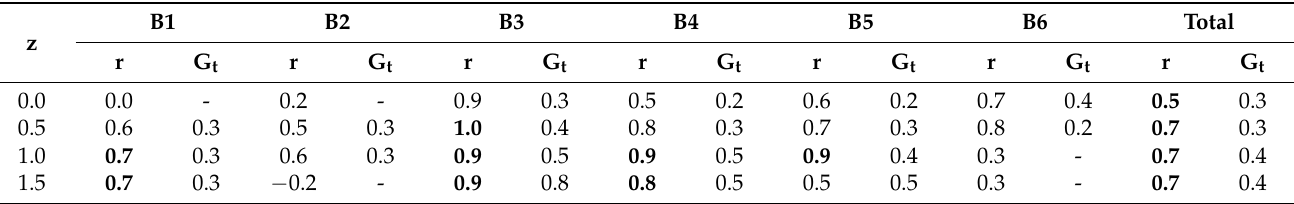
Table 3. Pearson’s coefficient (r) for the linear correlation between G 2.0 and ∆ T at different depths and for different boreholes and r is bold, when the p -value is less than or equal to the significance value of 5% and the correlation is thus significant. The table also lists the threshold gradient (G t ) above which ∆ T is considered significant based on a linear regression analysis. In this study only values of G 2.0 ≥ 0.0 m were